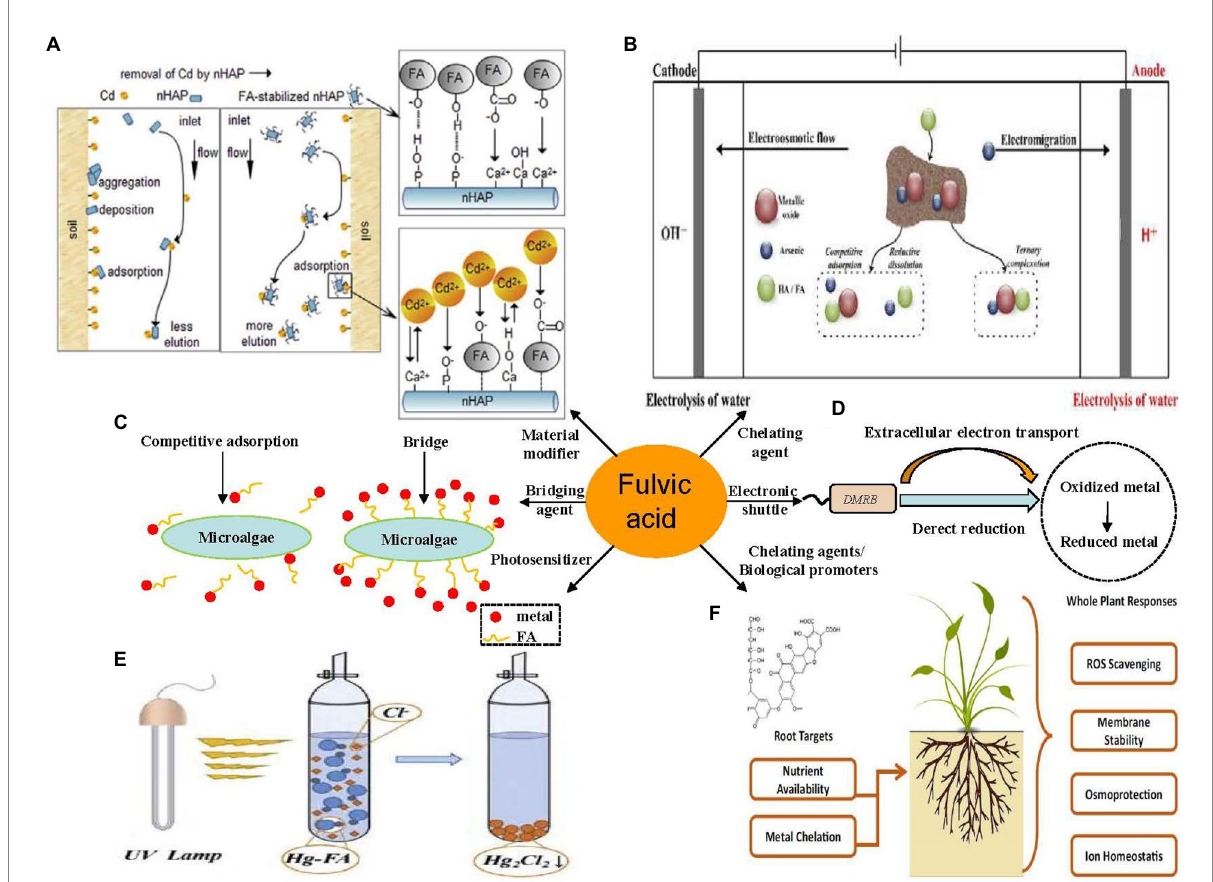
FIGURE 1 Main role of fulvic acid (FA) in physicochemical and bioremediation of metal contaminants. (A) Modification of nanomaterials (Li et al., 2019). (B) Electrokinetic remediation (Li J. et al., 2020). (C) Photodegradation (Fan et al., 2018). (D) Microalgal remediation. (E) Microbial remediation. (F) Phytoremediation (Van Oosten et al., 2017). All panels were obtained with the permission from